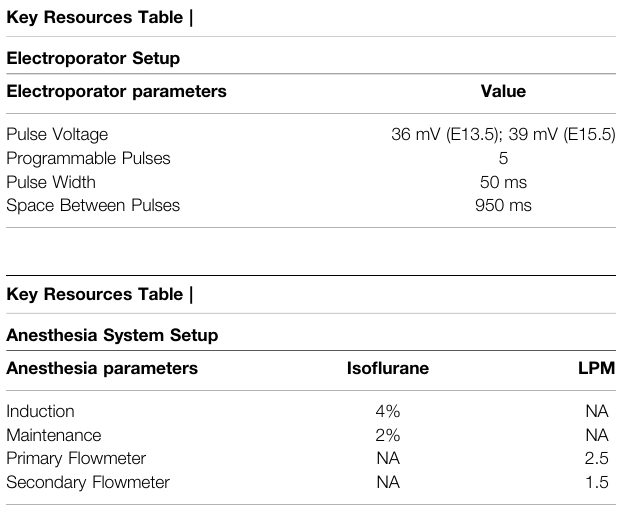
The table below uses 1.5 μ g/ μ L as an example. Dilute fast green to a fi nal concentration of 0.025%. PBS will be used to bring the fi nal volume to 10